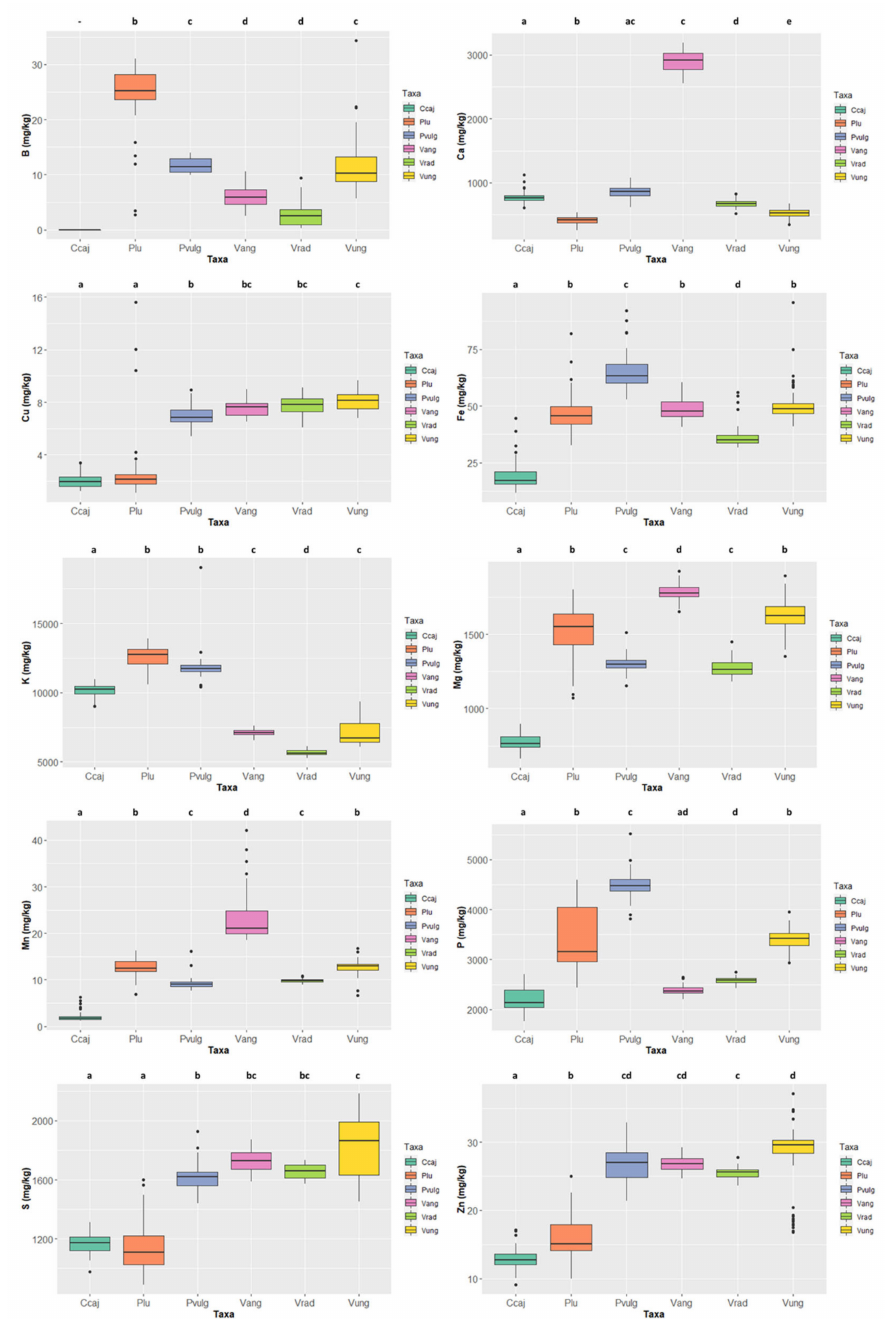
Figure 5. Variation of the content of the 10 minerals quantified in the six species ( Cajanus cajan , Phaseolus lunatus , Phaseolus vulgaris , Vigna angularis , Vigna radiata , and Vigna unguiculata ). The box represents the 25th, 50th (median), and 75th percentiles, while the whiskers represent the 10th and 90th percentiles with minimum and maximum observations. The dots represent the outliers. Different lower-case letters indicate significant differences ( p < 0.05) between